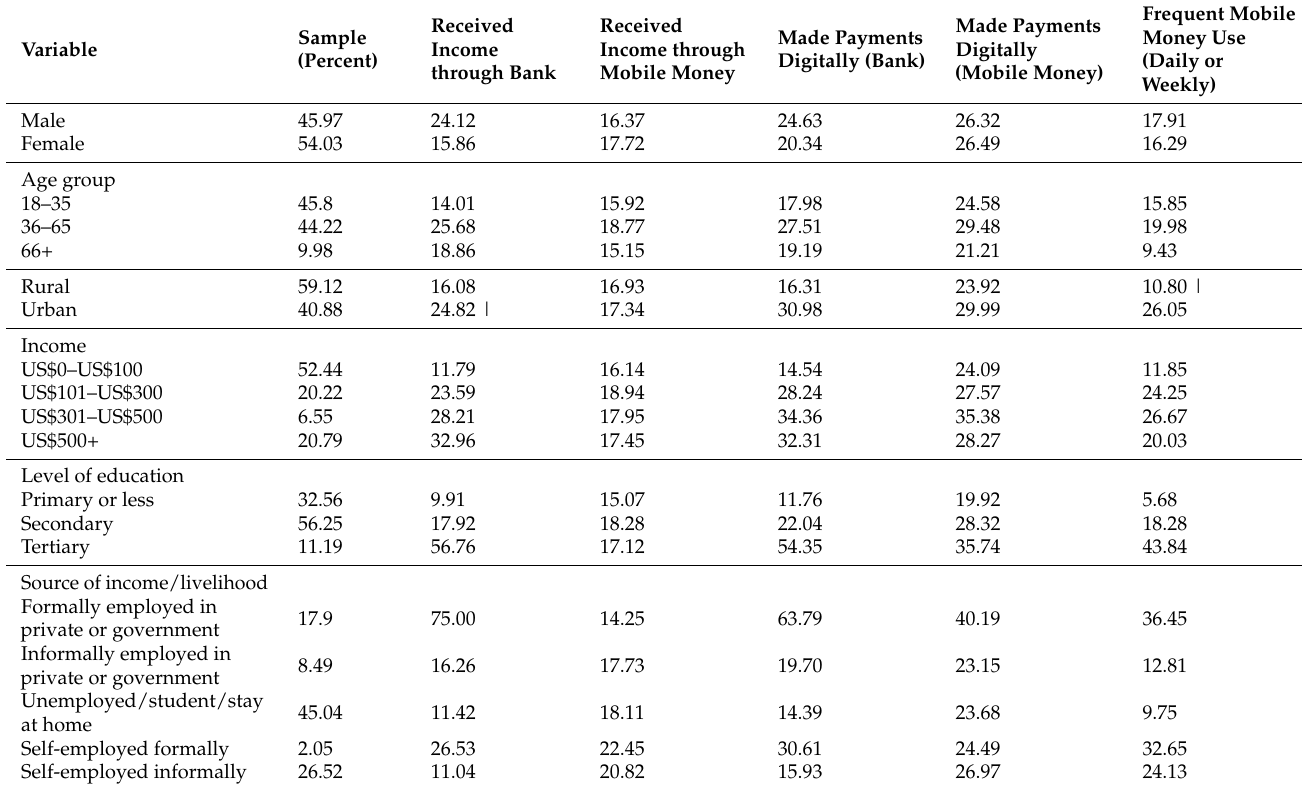
Table 2. Sample characteristics and descriptive